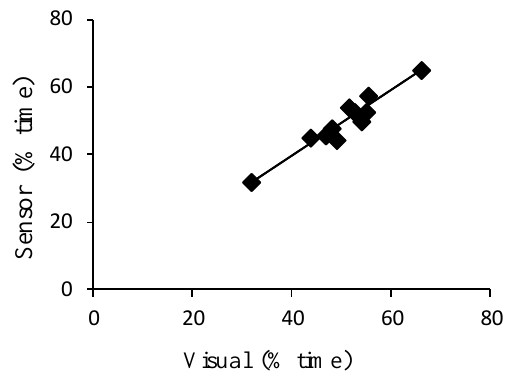
Figure 1. Percentage of daylight grazing time determined by visual observation and activity sensor. Visual observation values (X-axis) were compared with the activity sensor values (Y-axis) by linear regression analysis (Y = 1.33+0.97X, r 2 = 0.93). The intercept was not different from zero (p>0.05) and the slope was not different from one